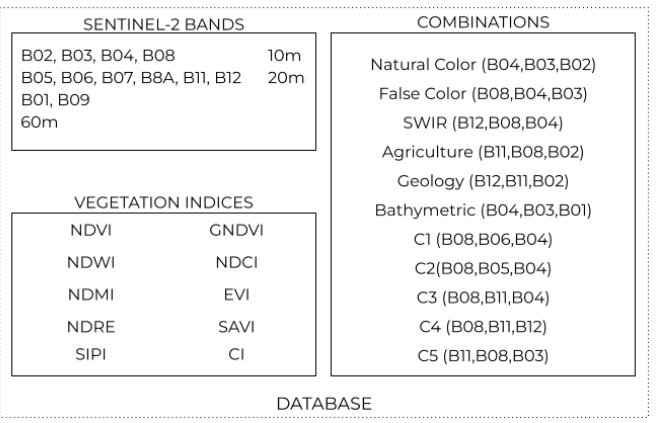
Figure 2. Database for the experiments. Each sample is composed of values from each Sentinel-2 band (except for band 10), vegetation indices, and combinations of the Sentinel-2 bands. Table 2. Vegetation indices were used in the studies to highlight the differences between sugarcane